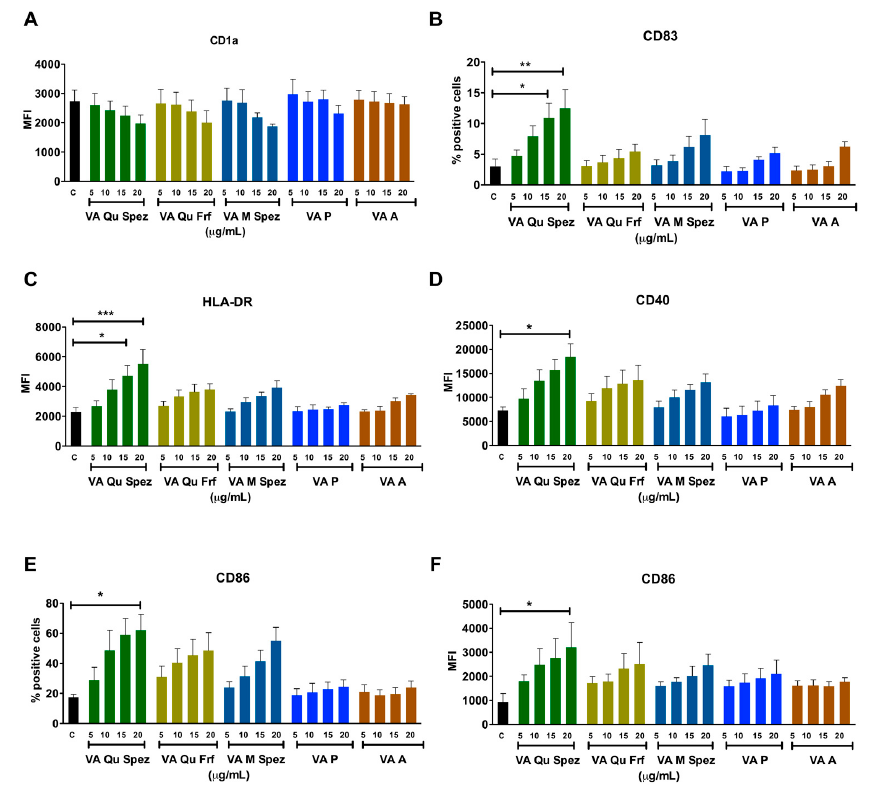
Figure 1. Differential effects of VA preparations on the phenotype of human DCs. Immature DCs were treated with medium alone (control, labelled as ‘C’) or with five preparations of VA (VA Qu Spez, VA Qu Frf, VA M Spez, VA P and VA A) at indicated concentrations for 48 h. Expressions (mean ± SEM, ≥ 4 independent donors) of ( A ) CD1a; ( B ) CD83; ( C ) HLA-DR; ( D ) CD40; ( E , F ) CD86 on DCs were analysed by flow cytometry. The data are presented either as % positive cells or MFI of indicated markers. X-axis denotes concentrations of VA preparations. * p < 0.05, ** p < 0.01,*** p < 0.001.